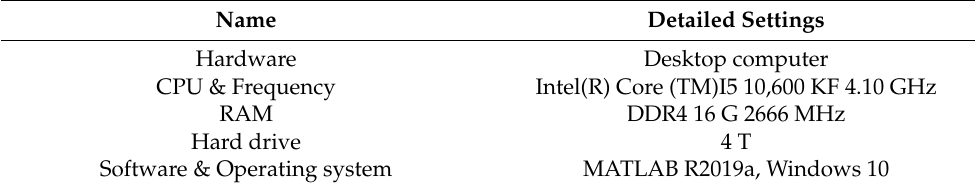
Table 2. Computer Table 2. Computer configuration.